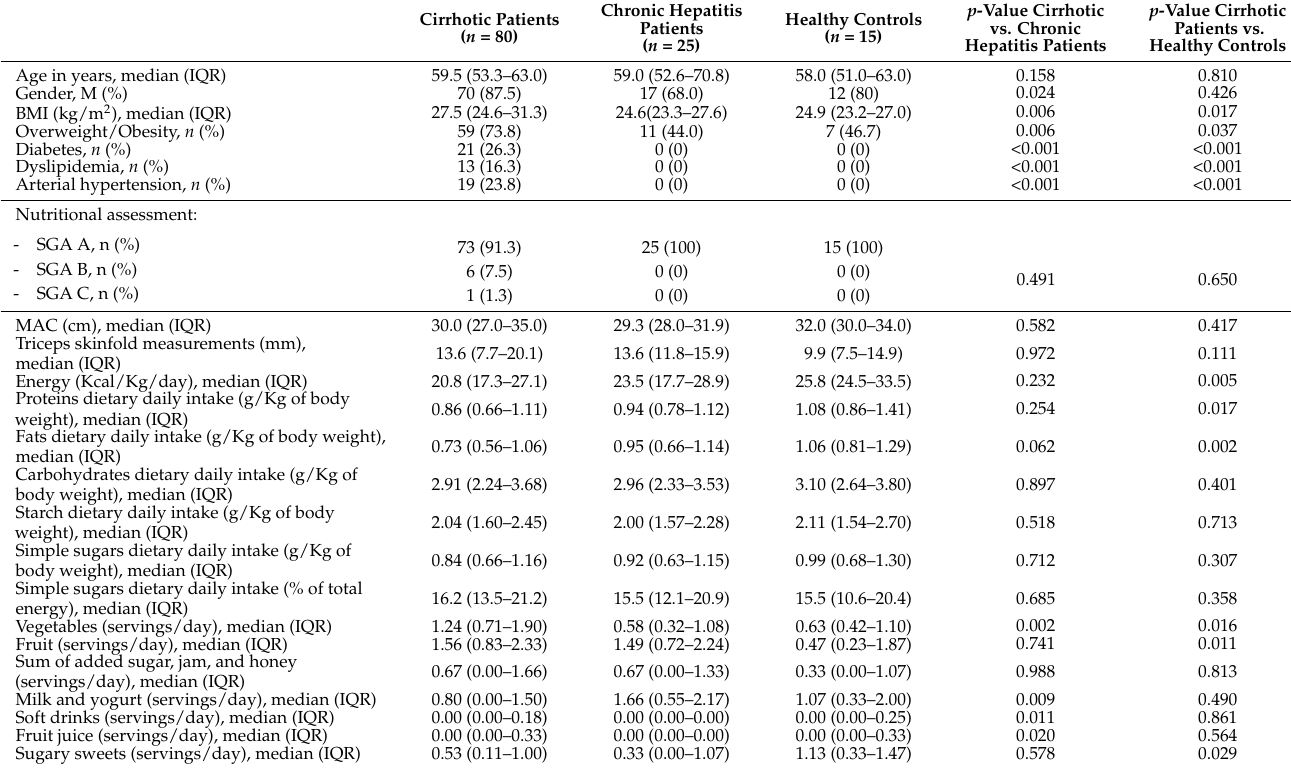
Table 1. Demographic, clinical, and nutritional characteristics of patients with cirrhosis, chronic hepatitis, and healthy controls. p -Value Cirrhotic p -Value Cirrhotic Chronic Hepatitis Healthy Controls Cirrhotic Patients vs. Chronic Patients vs. Patients ( n = 15) ( n = 80) Hepatitis Patients Healthy ( n = 25)